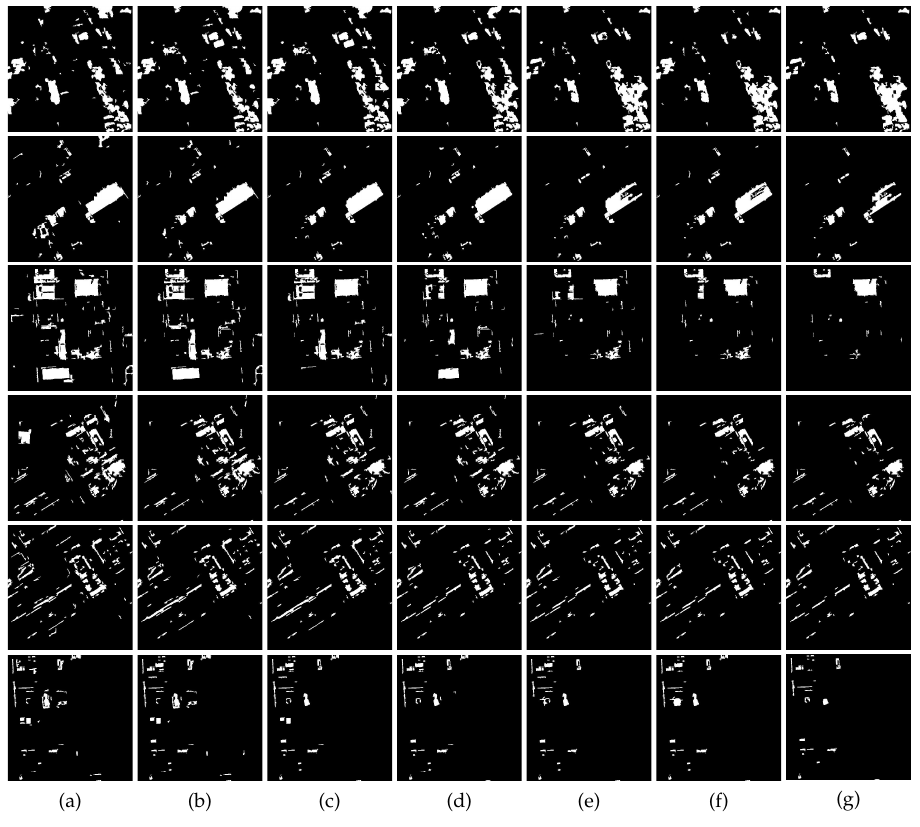
Figure 3. The influence of different clustering numbers. From top to bottom: corresponding results of the aforementioned two sets of image pairs; from left to right: different clustering numbers. ( a ) 2–4; ( b ) 2–6; ( c ) 2–8 (used in our experiments); ( d ) 2–10; ( e ) 2–12; ( f ) 2–14; ( g ) 2–16.